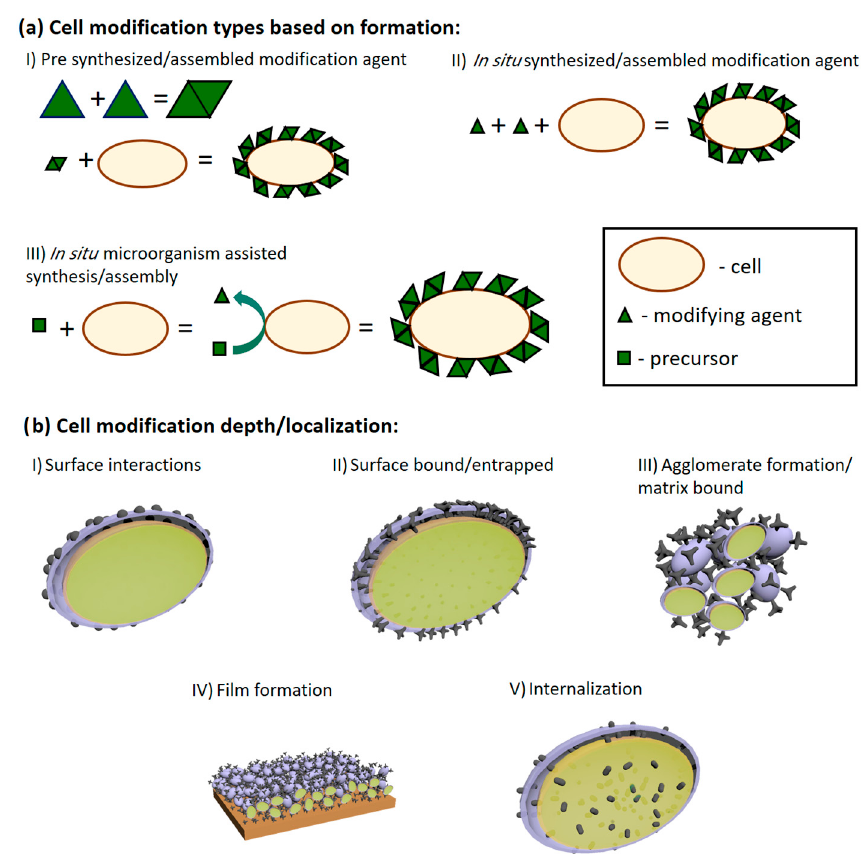
Figure 3. ( a ) Schematic depiction of cell modification by agent formation principle ( a ). Cells can be modified using pre-synthesized compounds (I), assembled/synthesized in situ in the presence of living cells (II), and in situ when the cells assist/catalyze the synthesis assembly of the modifying agent (III). ( b ) Schematic representation of modifying agent localization in MBFC applications: (I) surface interactions as adsorption and electrostatic interactions; (II) modifying agent is either covalently bonded or forms interlacing and inseparable structures with cell walls or other similar structures; (III) when modifying agent forms aggregates from its matrix and cells; (IV) higher agglomerate organization onto surfaces; (V) internalization of modification agent. In picture ( b ), the purple surface represents the cell wall; the light green part of the picture represents the inside of the cells; the dark green parts of the picture show the modifying agents. Adapted from [7].